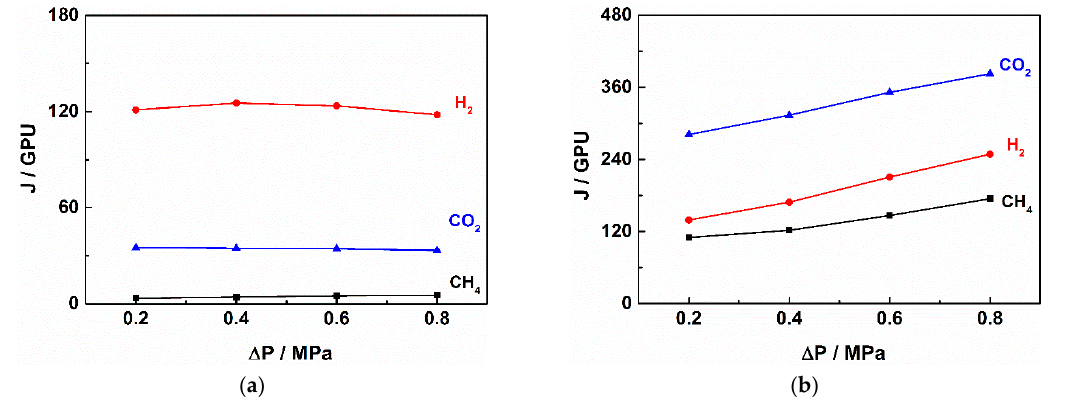
Figure 7. Effects of operating pressure on membrane performances. ( a ) PI membrane gas permeation rates; ( b ) PDMS / PEI membrane gas permeation rates.